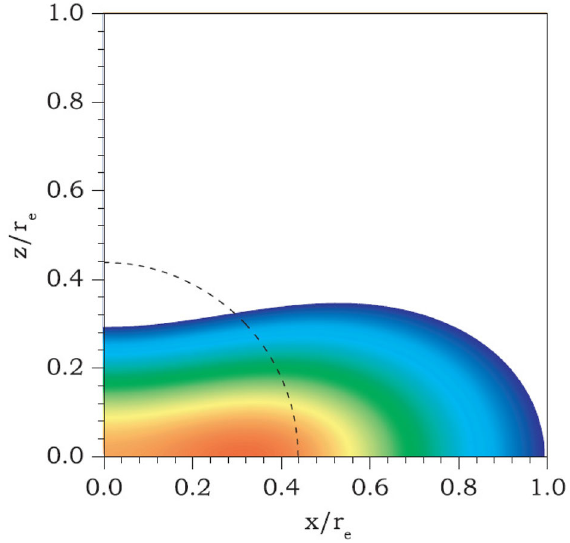
Fig. 8 Density stratification for model A11 of Table 4, displaying an off-center density maximum. In comparison, the shape of the nonrotating star of same rest mass is shown, scaled by the equatorial radius of therotatingmodel(dashedline).(ImagereproducedwithpermissionfromStergioulasetal.2004,copyright by RAS)